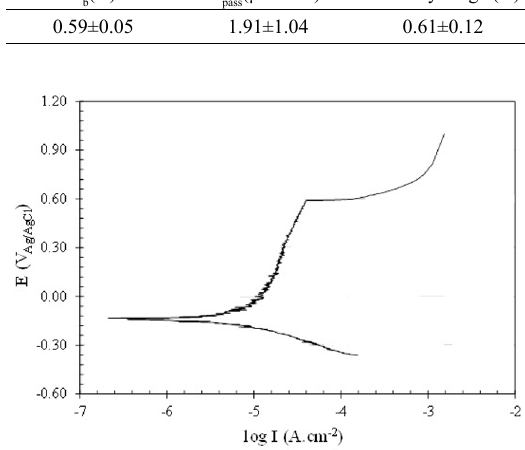
Figure 13. SEM micrograph of the AISI 409 stainless steel after potentiostatic polarization in 0.1 M NaCl solution at room